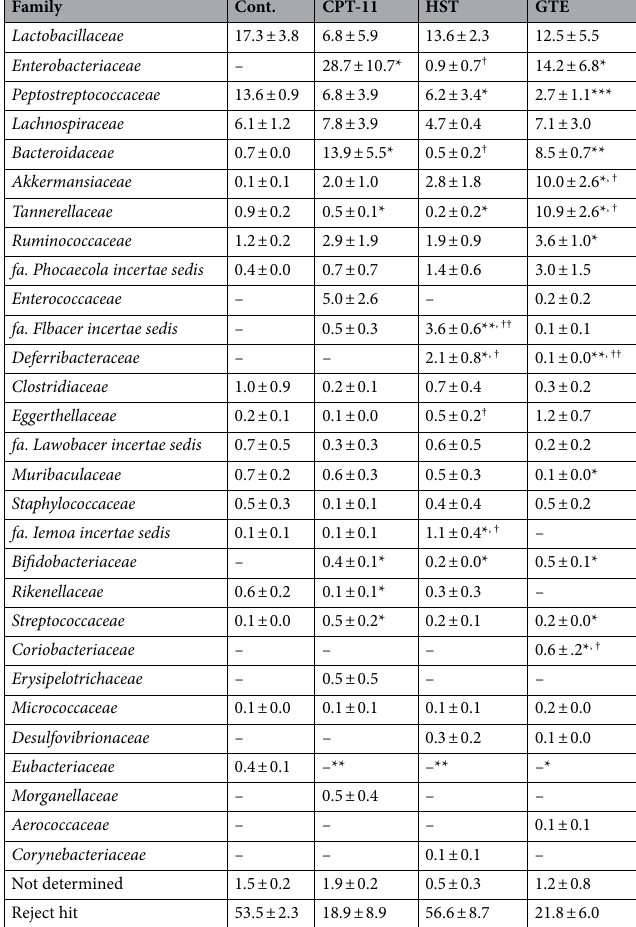
Table 2. Family level proportions of gut microbiota. Rats were administered CPT-11 or lactic acid buffer intravenously for 4 days, and HST or GTE was administered in combination. The relative abundance at the family level in the gut microbiota was measured by next-generation sequencing. “–” indicates that the value is greater than 0 and less than 0.1 (mean ± S.D., n = 3, * p < 0.05, ** p < 0.01, *** p < 0.001 vs. Cont., † p < 0.05, †† p < 0.01 vs.